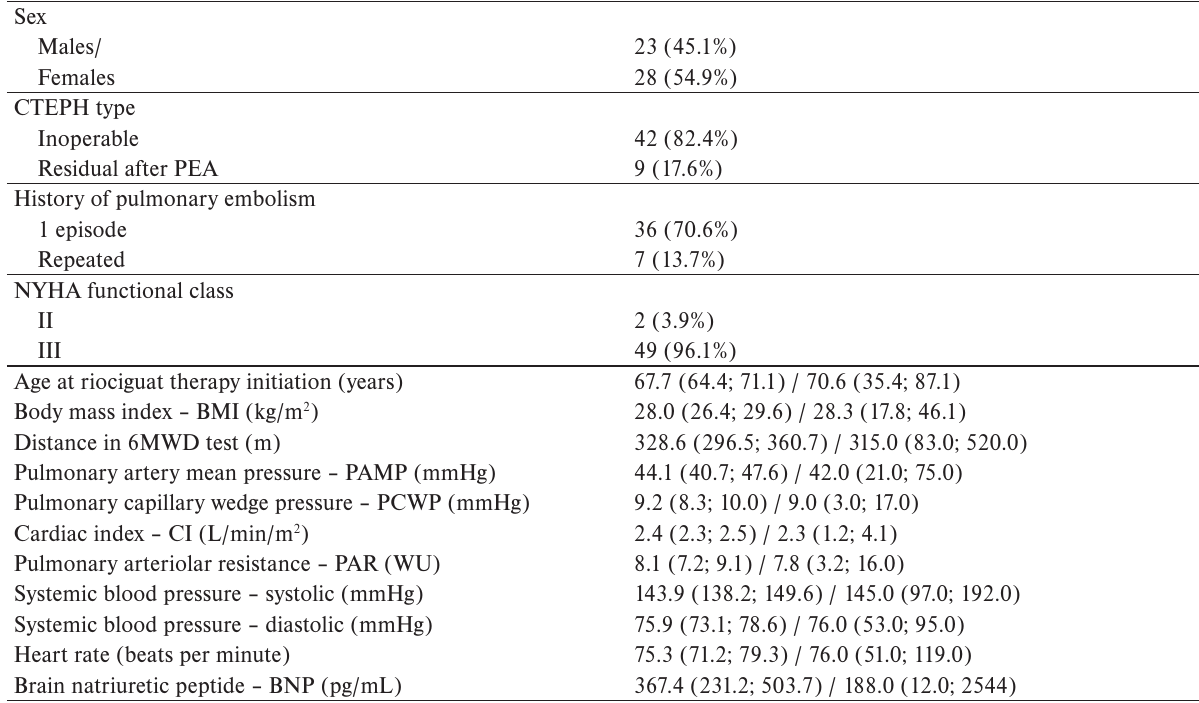
Table 1. Population